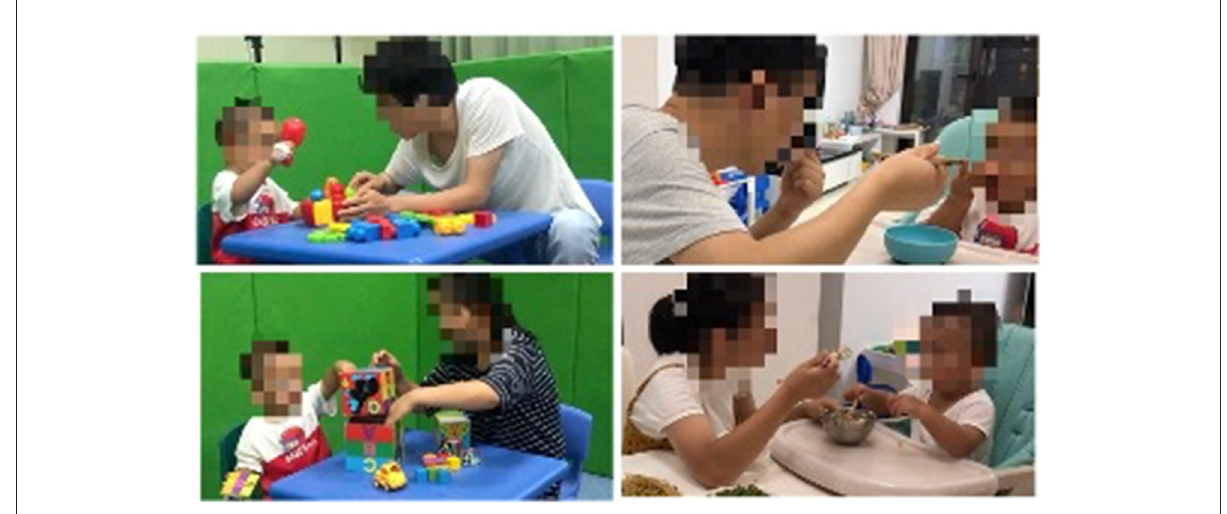
FIGURE1 Caregiver-toddler interaction video scene setup and context. Both of the two caregivers complete the video of play and dining activities with their